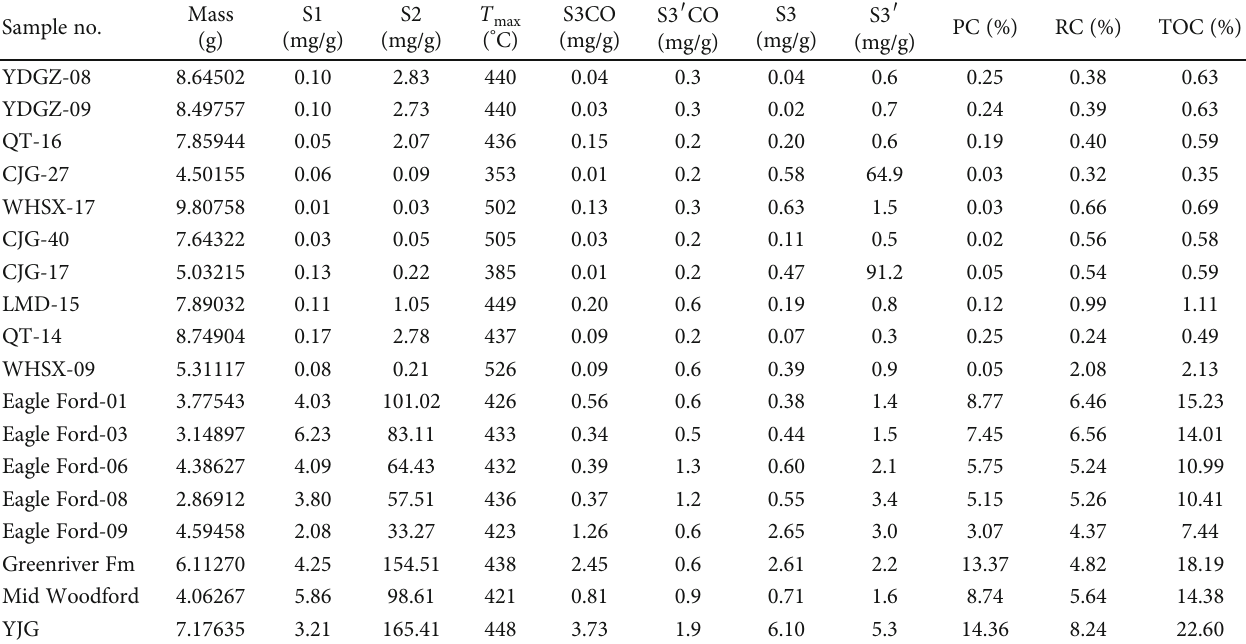
Table 2: The results of rock-eval pyrolysis for rock residues after acid treatment. Sample